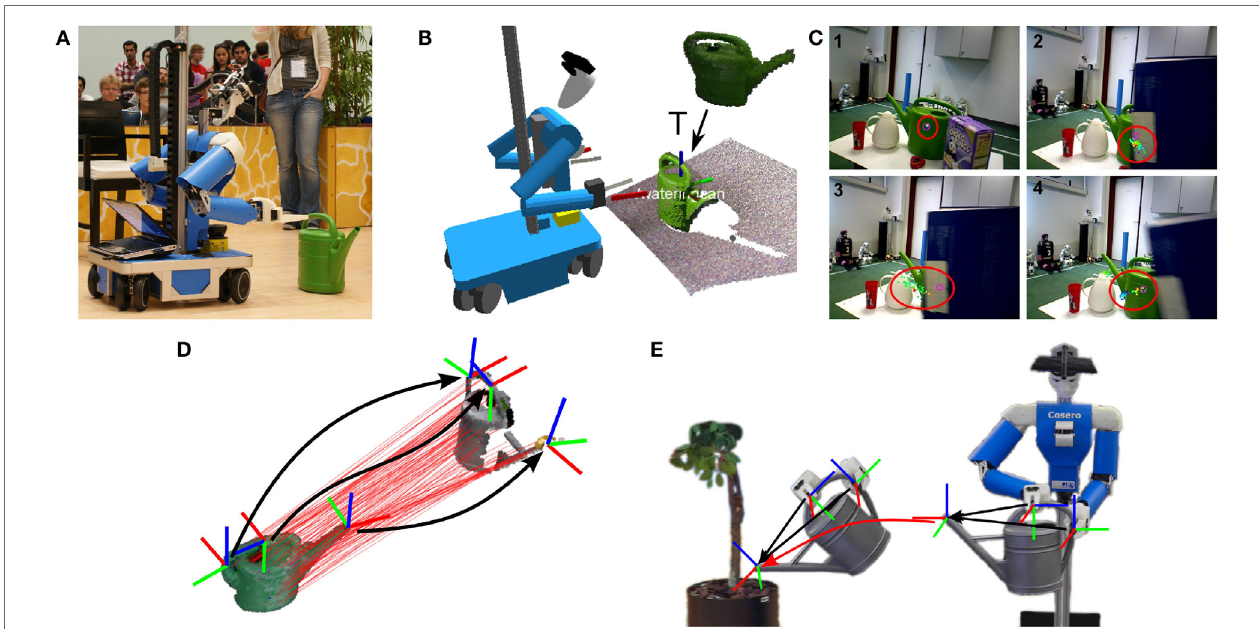
FIgURe 8 | object tracking using registration of object models . (A) Cosero approaching a watering can. (B) We train multiview 3D models of objects using multiresolution surfel maps. The model is shown in green in the upper part. The model is registered with the current RGB-D frame to estimate its relative pose T, which is used to approach and grasp the watering can (Stückler et al., 2013a). (c) Joint object detection and tracking using a particle filter, despite occlusion (McElhone et al., 2013). Object manipulation skill transfer (Stückler and Behnke, 2014b): (D) an object manipulation skill is described by grasp poses and motions of the tool tip relative to the affected object. (e) Once these poses are known for a new instance of the tool, the skill can be transferred.